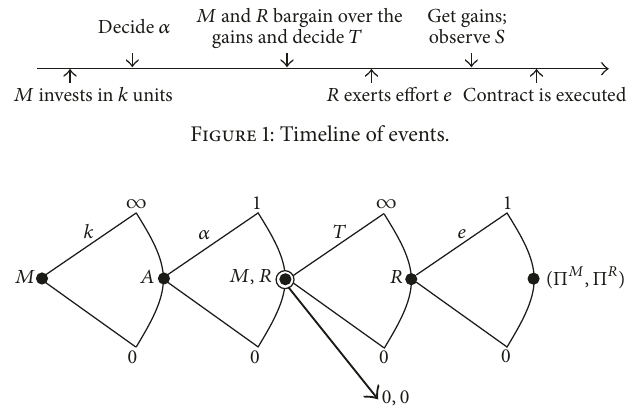
Figure 2: Dynamic game between manufacturer and